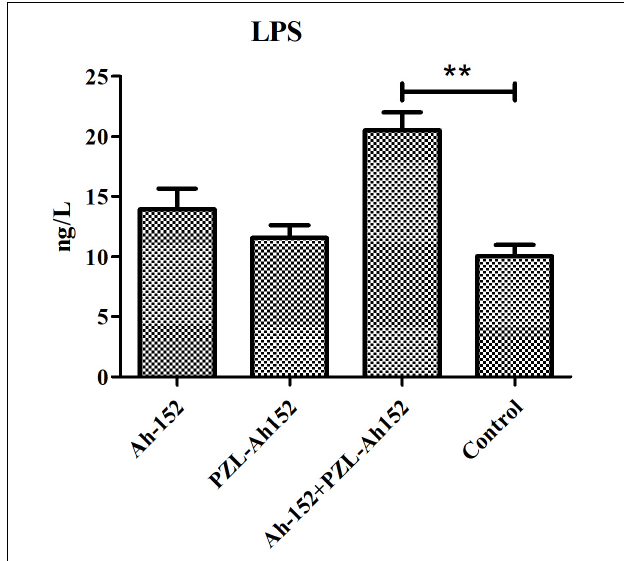
FIGURE 8 | Determination of LPS content in intestinal contents of crucian carp. Ah-152: challenged i.p. with 2 × 10 8 CFU of A. hydrophila 152 per fish. Ah-152+PZL-Ah152: challenged with A. hydrophila 152 (2 × 10 9 CFU/ml, 100 µ L/fish) , 1 h later injected i.p. with 2 × 10 9 of PZL-Ah152. PZL-Ah152: injected i.p. with 2 × 10 9 PFU PZL-Ah152; Control: not treated. ** p < 0.01.